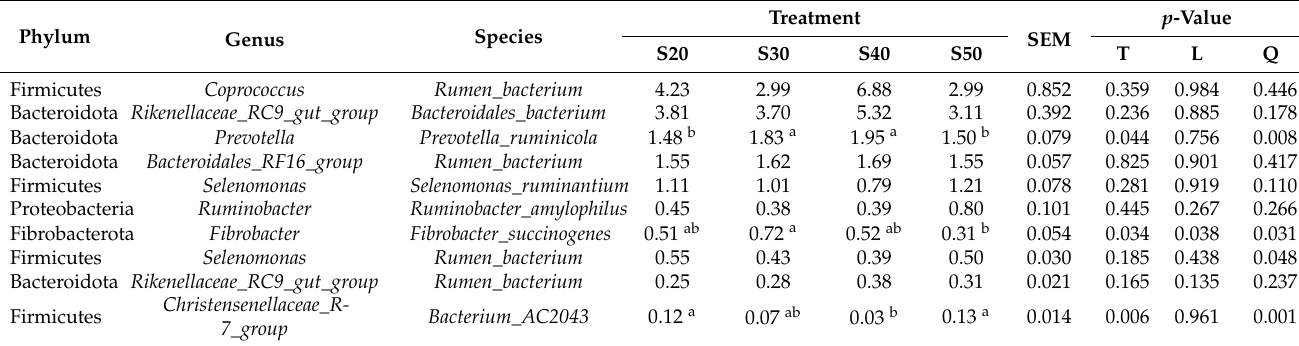
Table 6. The effect of substrate SP (% of CP) levels on the relative abundance of bacterial species at 24 h of culture in vitro